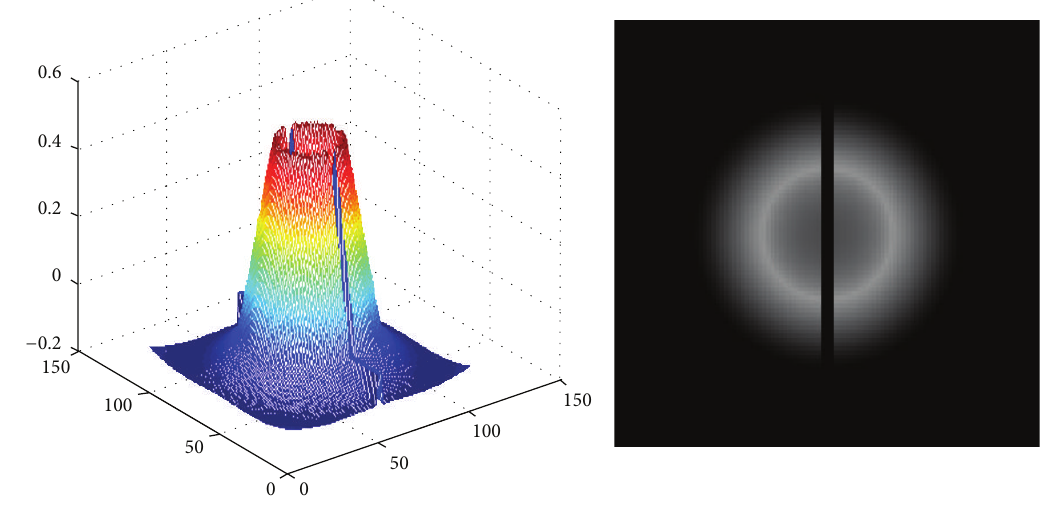
Figure 2: Optic disc template [12].